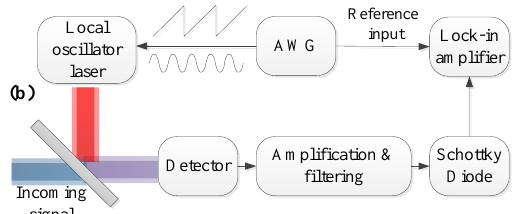
Figure 10. Schematic diagram of typical system configuration for ( a ) traditional LHS and ( b ) WMS-LHS.